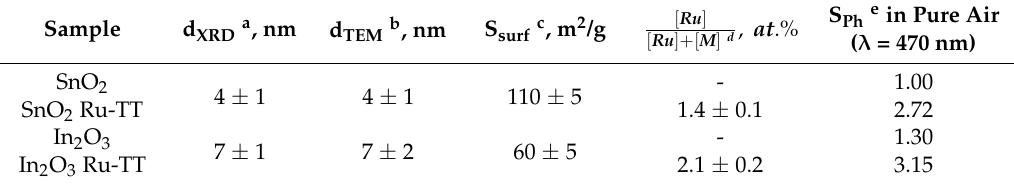
Table 2. Microstructure characteristics, composition and photoresponse of investigated samples.